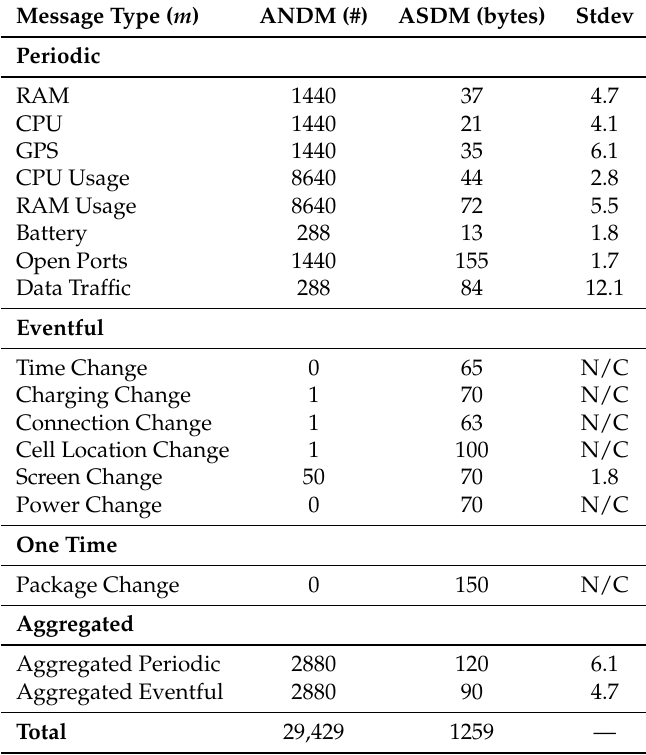
Table 7. Device message daily frequency